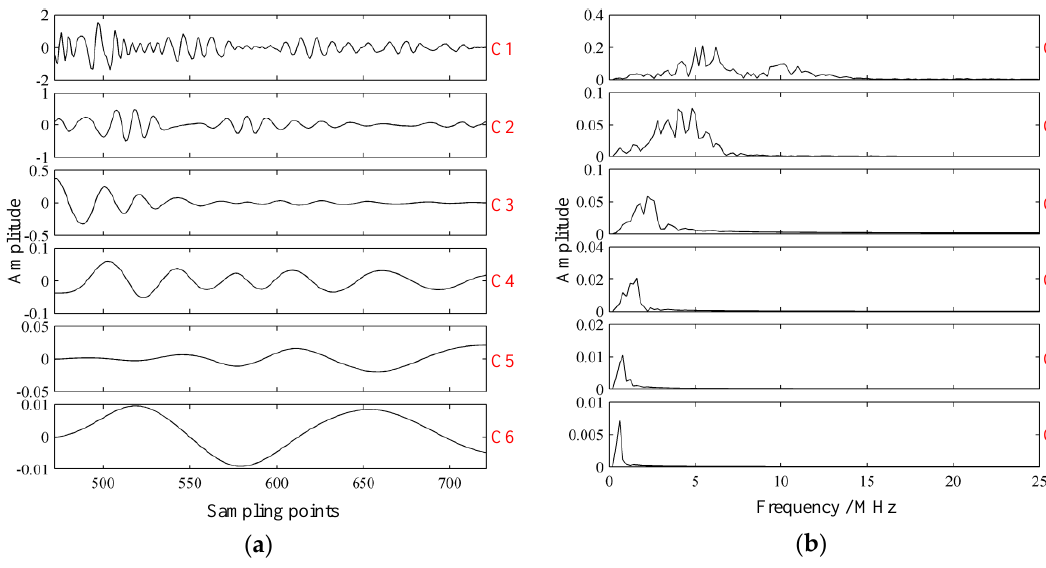
Figure 10. Modes extracted of the experimental signal via empirical mode decomposition. ( a ) Intrinsic mode functions; ( b ) spectrums of intrinsic mode functions.